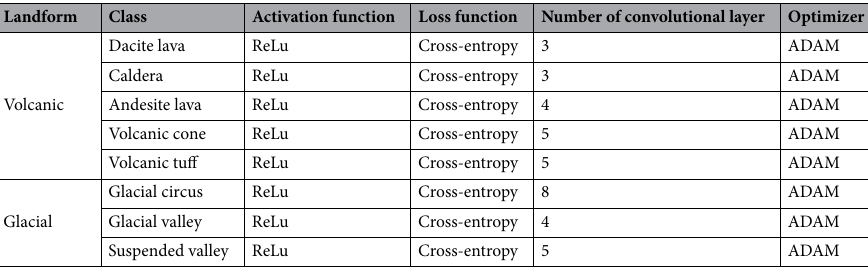
Table 6. Characteristics of employed GEOBIA-CNN models for volcanic and glacial